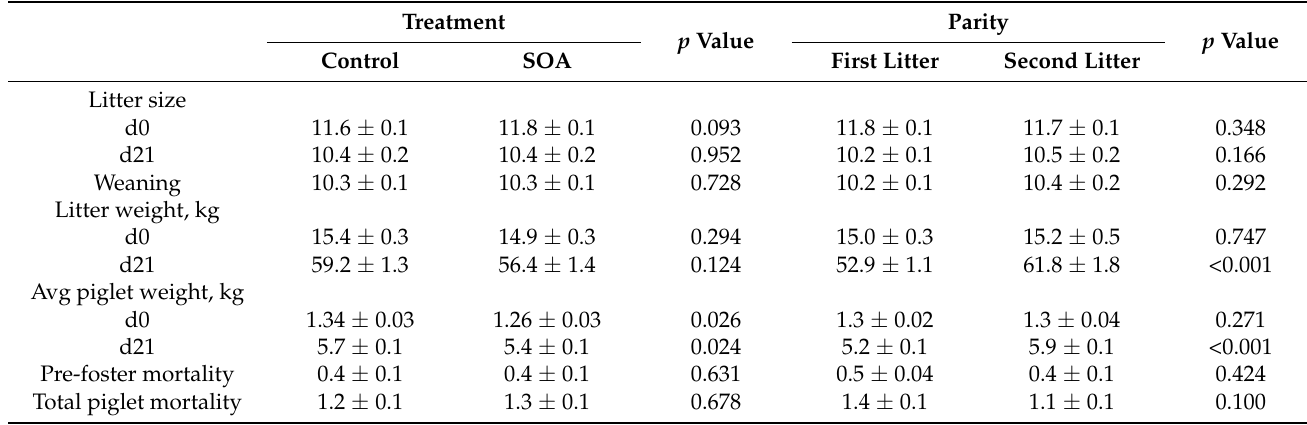
Table 3. Effect of the synthetic olfactory agonist (SOA) and Control treatments on piglet measurements within a commercial research setting (mean ±